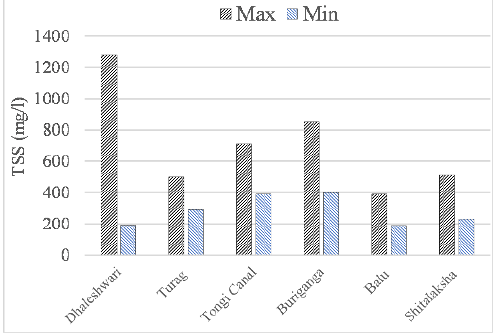
Figure 7. Max m vs. Min m Concentration of TSS for the peripheral rivers of Dhaka for TSS.